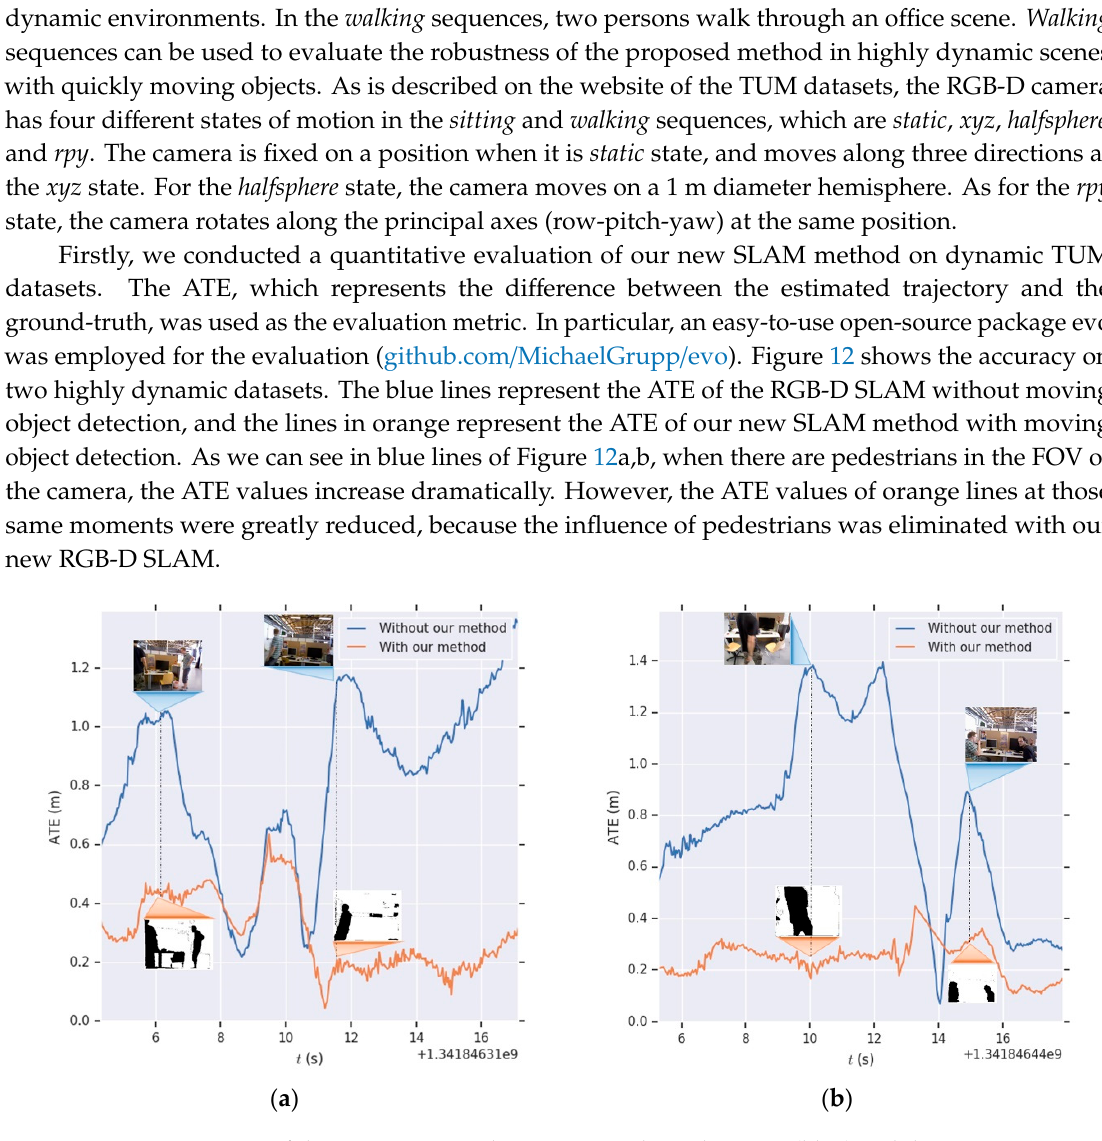
Figure 12. Accuracy of the experiment without moving object detection (blue) and the experiment with our new method (orange) on two highly dynamic datasets. The horizontal axis represents time in seconds, and the longitudinal axis represents the absolute trajectory error (ATE) in meters. ( a ) 1341846315–1341846327 s part of the fr3/walking_xyz dataset; ( b ) 1341846446–1341846457 s part of the fr3/walking_halfsphere dataset. The RGB images of blue lines indicate the presence of pedestrians in the FOV of the camera. The black areas in the binary images of orange lines indicate that our improved RGB-D SLAM excluded the influence of pedestrians at these moments when ATE values increased dramatically.